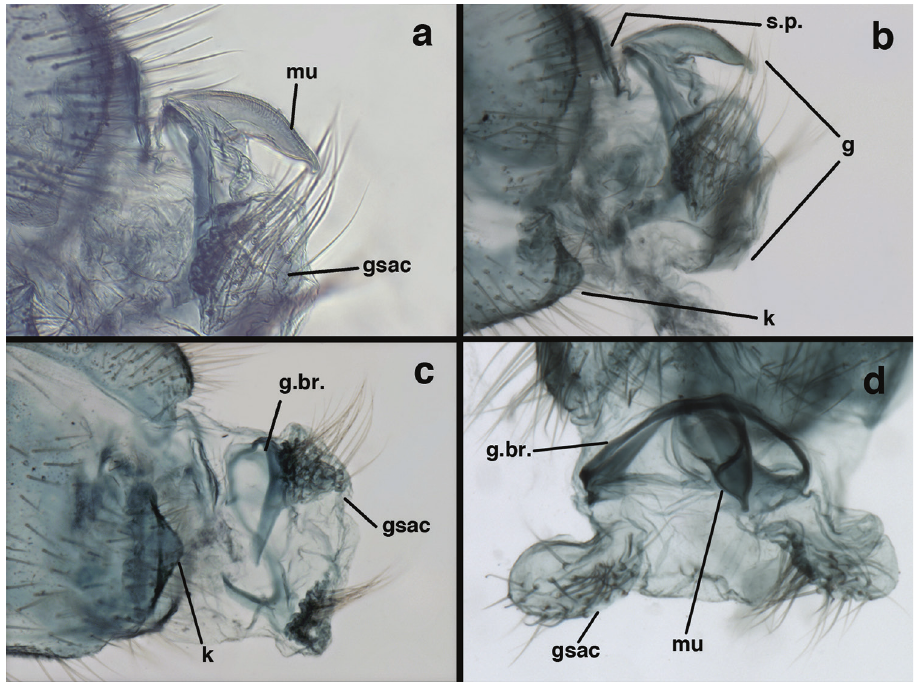
Figure 92. Ungla stangei Tauber, sp. n. Male genitalia (teneral), ( a ) gonarcus, posterolateral ( b ) gonarcus and tip of S9, lateral ( c ) S8+9 ventral [Note sclerotized knob at tip of S9.] ( d ) gonarcal complex, dorsal g gonarcal complex gsac gonosaccus g.br. gonarcal bridge k sclerotized knob at tip of S9 mu mediun- cus s.p. setose subanal plate (all: Bolivia, La Paz; a–c paratype, CAS; d holotype,